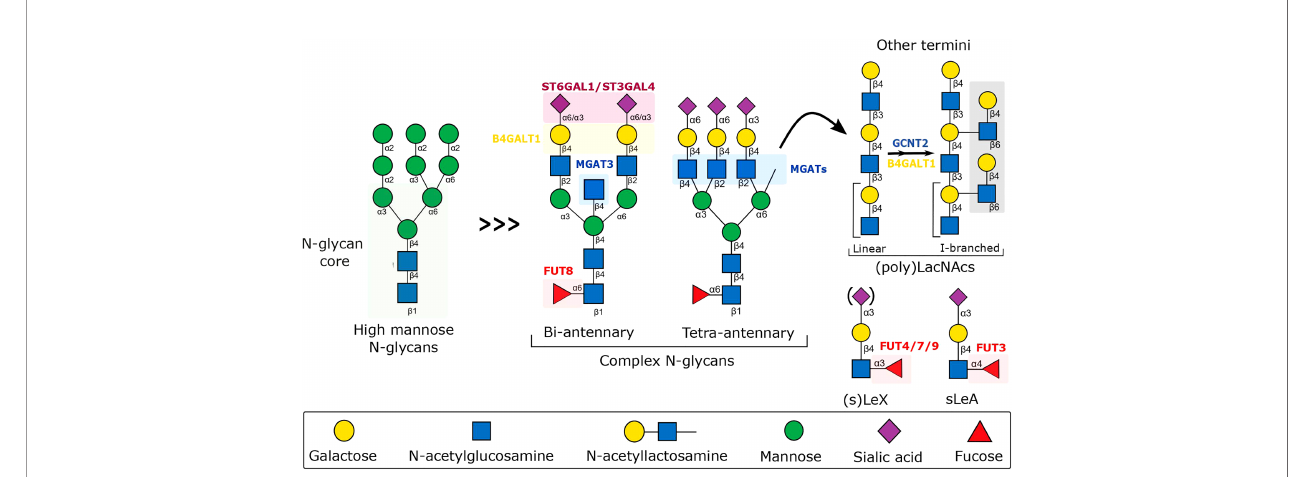
FIGURE 2 | Schematic representation of the biosynthesis of N-glycans involved in the fi ne-tuning of the immune response to in fl ammation. The schematic includes the major N-glycan structures found on the surface of endothelium, immune cells, and secreted molecules, along with the relevant glycosyltransferases, whose expression has been shown to be modulated by in fl ammatory cytokines, dramatically affecting glycan-dependent interactions important for leukocyte immune regulation. B4GALT1, Beta-1,4-Galactosyltransferase 1; FUT, Fucosyltransferase; GCNT2, Glucosaminyl (N-acetyl) Transferase 2; MGAT, N-acetylglucosaminyltransferase; ST6GAL4, Beta- Galactoside Alpha-2,3-Sialyltransferase 4; ST6GAL1, Beta-Galactoside Alpha-2,6-Sialyltransferase